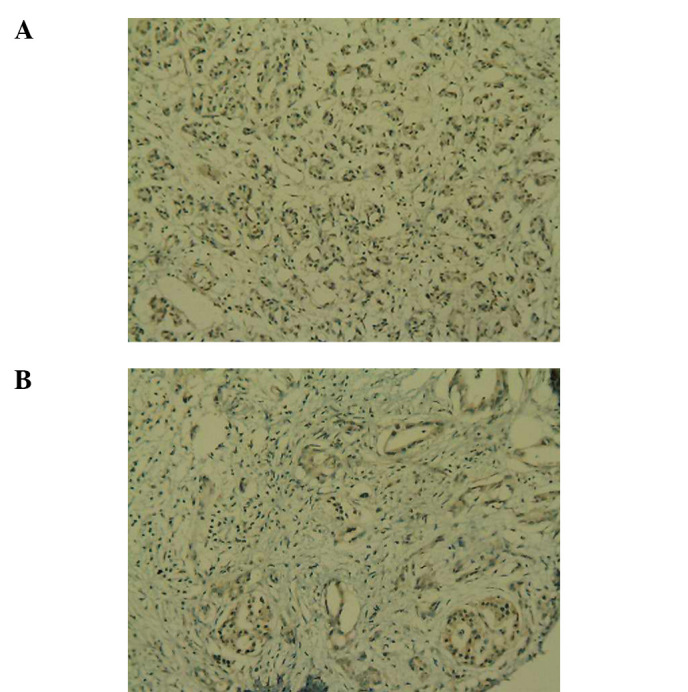
Immunohistochemical staining for C3. (A) Low C3 expression in normal pancreatic tissue. (B) High C3 expression in pancreatic cancer tissue (magnification, ×200).